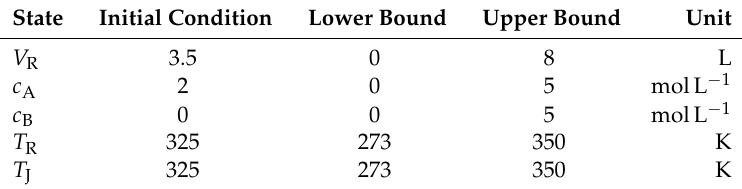
Table 4. Case study 1: Initial conditions of the states along with practical